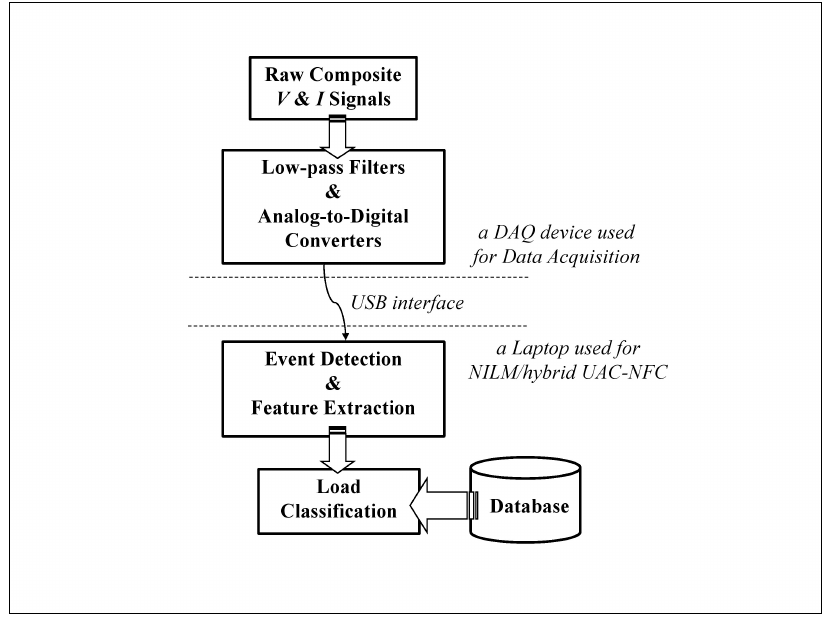
Figure 2. Workflow of a typical NILM.